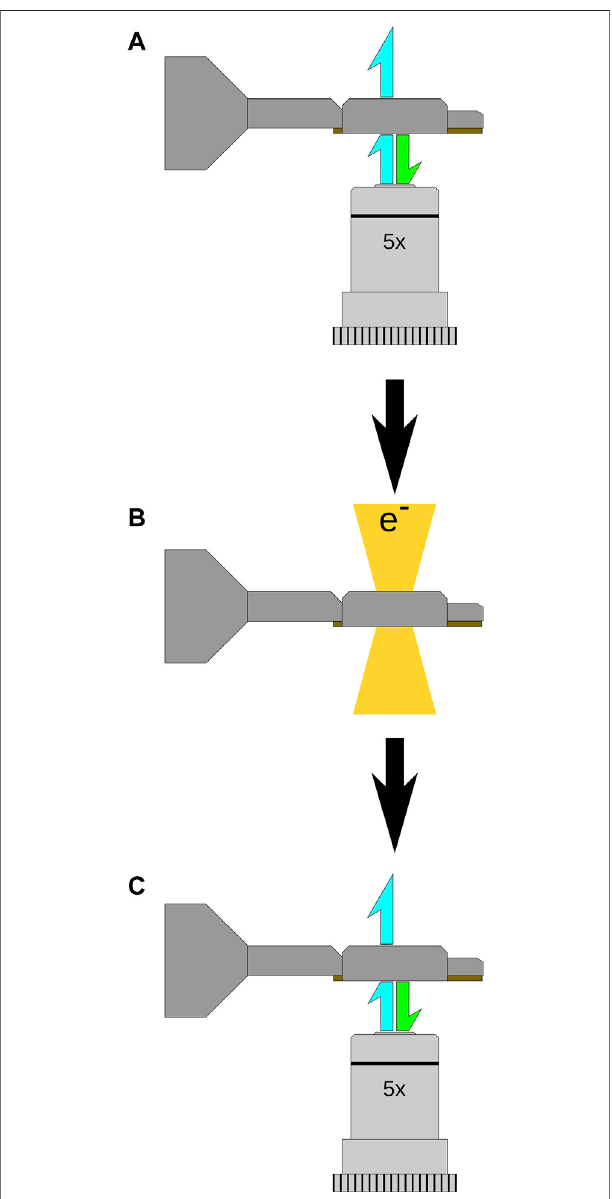
FIGURE3|(A) Illustrationofthe fl uorescent imagingstrategy,where the liquid cell was imaged from below the liquid cell tip with a 488 nm laser generating a bright fi eld and fl uorescent image (B) Illustration of electron irradiation, where the orientation of the liquid holder was always such that the lipid bilayer was always on the top of the liquid cell. (C) Illustration of the fl uorescent imaging strategy after electron irradiation, where bright fi eld and fl uorescent images were collected of the liquid cell immediately post